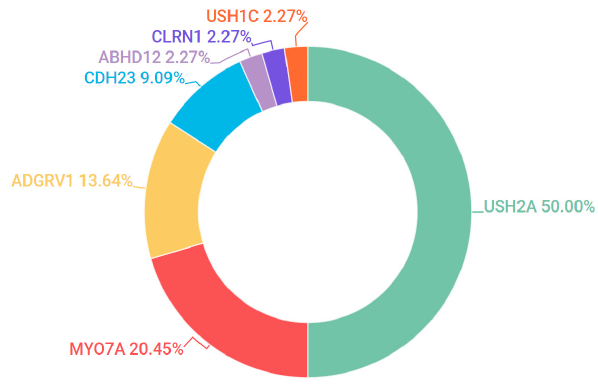
Figure 6. Gene candidates (and percentages) found across all subtypes of Usher Syndrome.